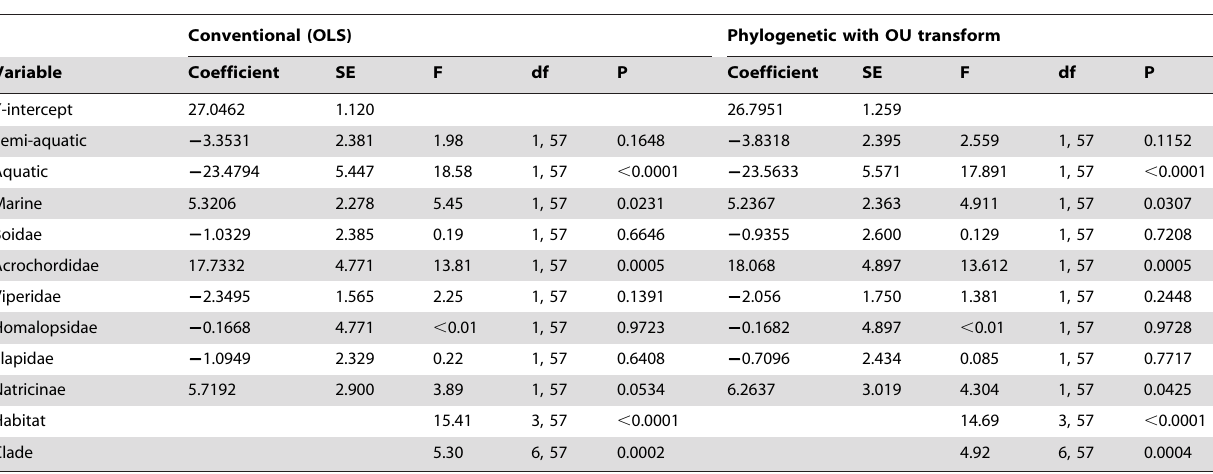
Table 2. Full models to predict